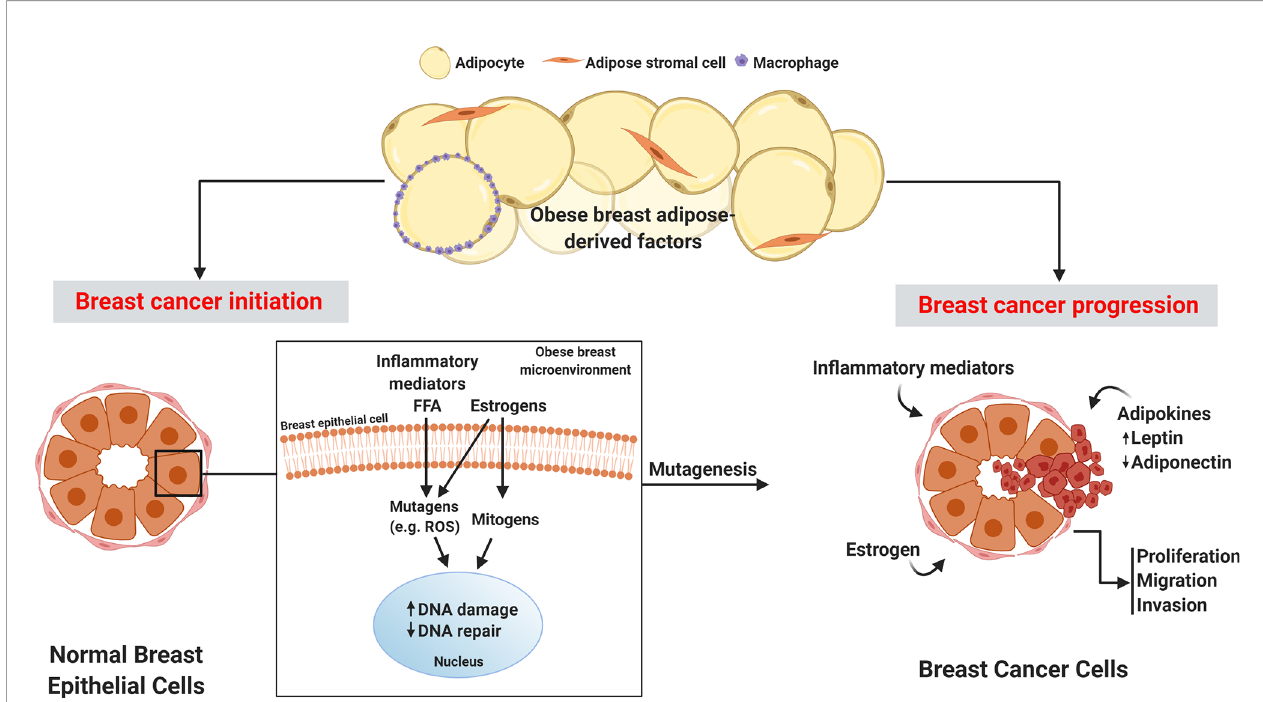
FIGURE 1 | Obese breast adipose-derived factors contribute to the initiation and progression of breast cancer. Factors produced by obese breast adipose tissue including in fl ammatory mediators, free fatty acids (FFA), and estrogens can act as mutagens, for example by stimulating intracellular reactive oxygen species (ROS), which can lead to DNA damage in normal breast epithelial cells. Estrogen also has mitogenic effects that can lead to replication stress and consequently DNA damage. Elevation in DNA damage coupled with potential estrogen-induced dysfunctional DNA repair may lead to unresolved DNA damage, which is linked to mutagenesis and initiation of cancer. Breast cancer progression is fueled by in fl ammatory mediators, excess leptin, decreased adiponectin, and elevated estrogens in the obese breast adipose microenvironment which promote proliferation, migration, and invasion of breast